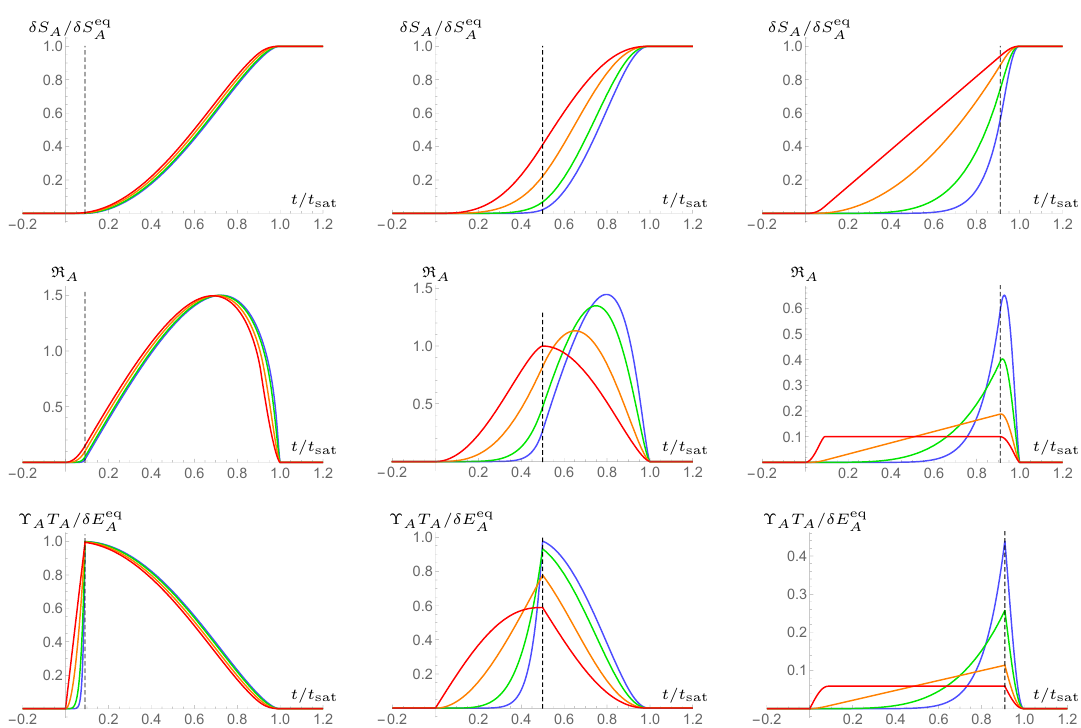
A ( t ), instantaneous rate of growth R A ( t ) and time- 1 ; 2 ; 5 ; 10 , f g = 0 : 1 ; 1 ; 10 from left to the right. In all f g (cid:3)